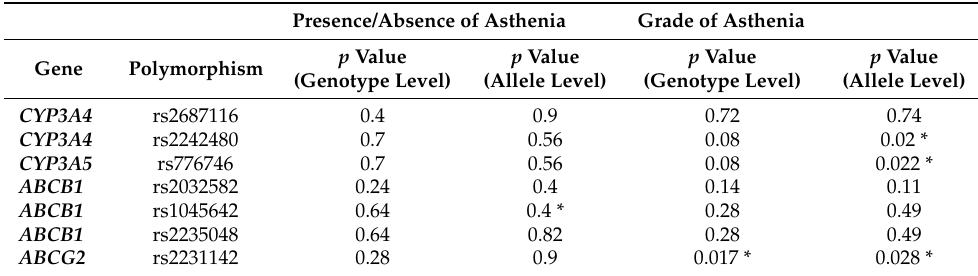
Table 9. p value by chi-squared test at genotype and allele level for the presence/absence and grade of asthenia. Correlation between asthenia side effect and polymorphisms linked to MKI metabolism.